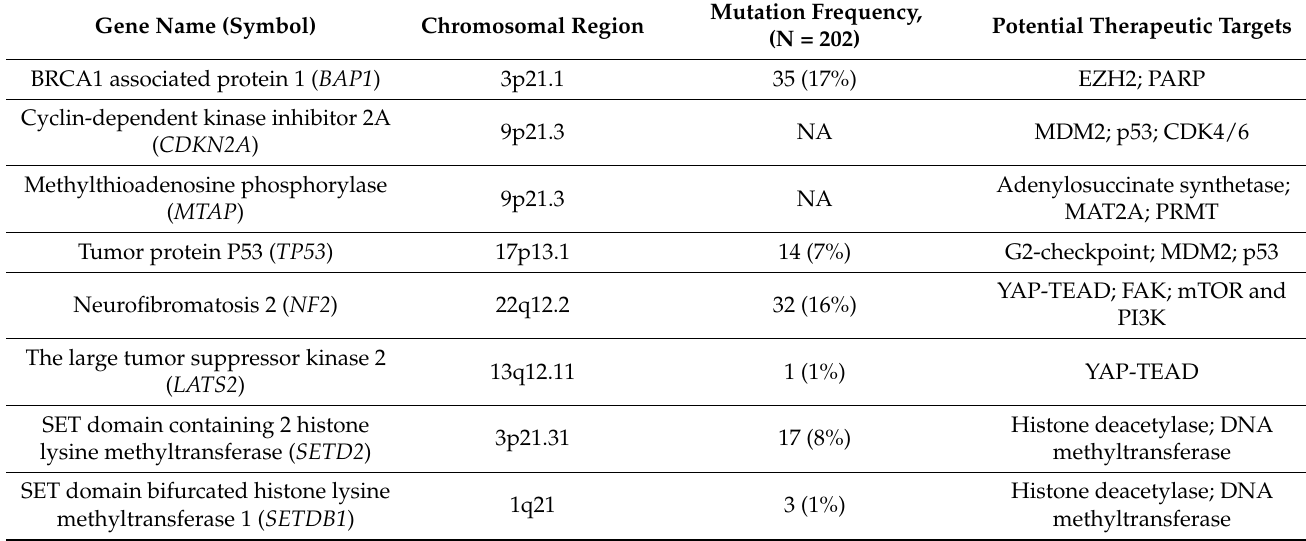
Table 1. Common somatic mutations in PM reported by Bueno et al. [11] and their potential therapeutic targets.